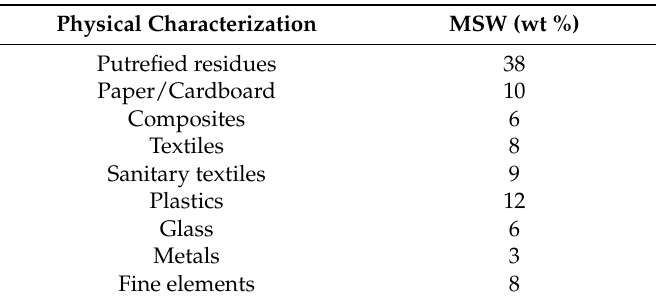
Figure 3. Average physical characterization of MSW produced in Portugal in 2015. Table 1. Physical characterization of the MSW used in this study [16].